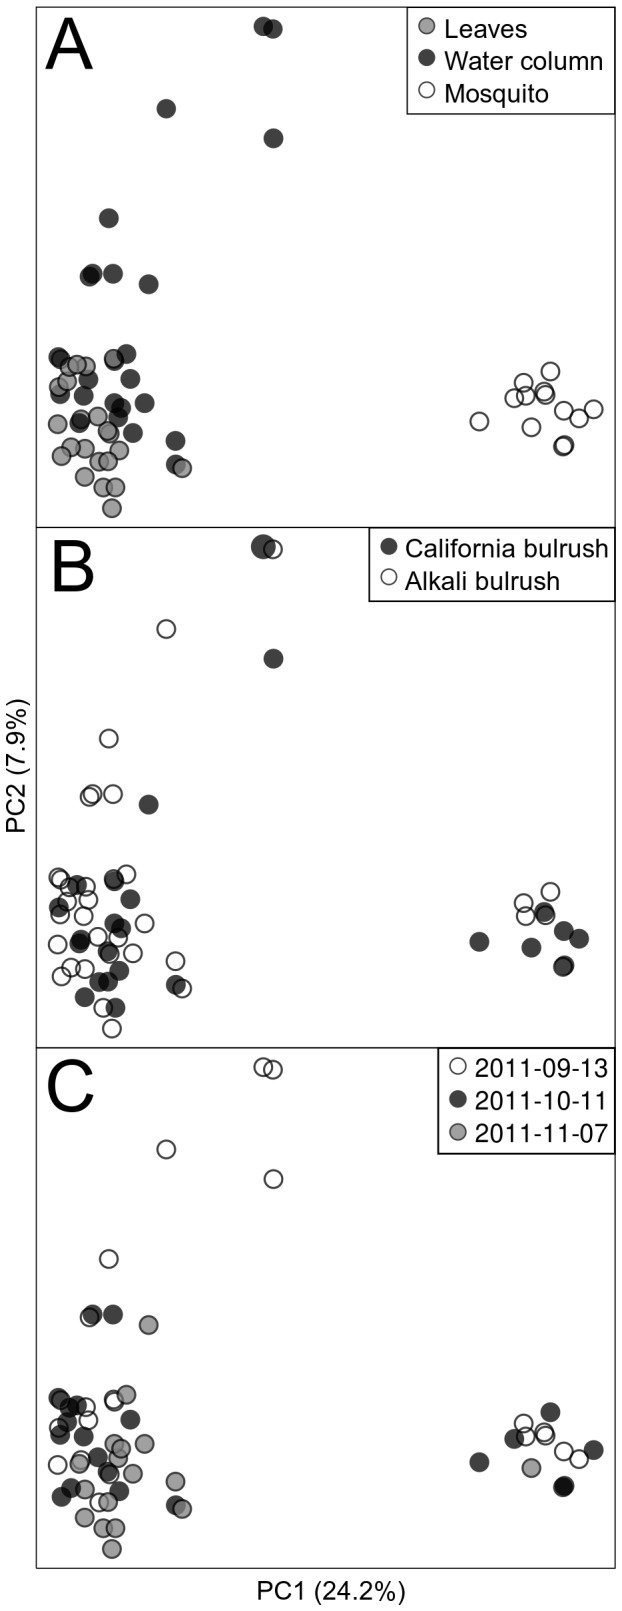
Community similarity of OTU profiles representation.PCoA plots based on Bray-Curtis distances of OTU profiles mosquitoes, water and leaf samples from mesocosms containing the two bulrushes from the different sampling dates. Panel A shows points colored by DNA source. Panel B shows points colored by the plant present in the mesocosm. Panel C shows points colored by sampling date.